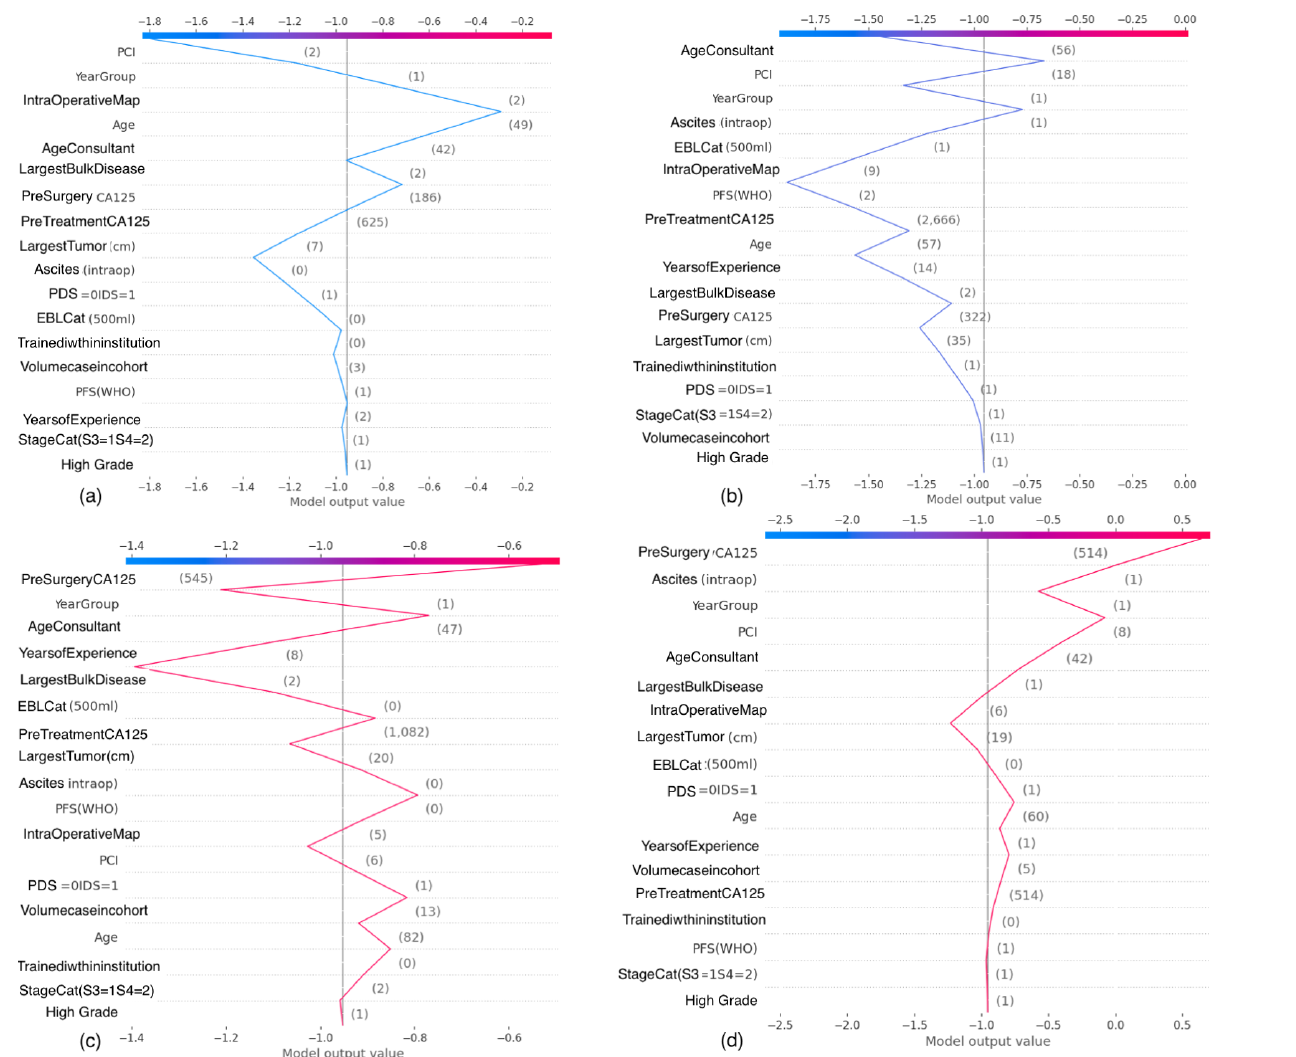
Figure 7. Examples of Decision plots based on feature integration by the XAI model into a single risk for prediction of surgical effort. For the probability of SCS > 4, blue features have values that increased the probability, while red features decreased the probability. The combination of impacts of all features is the predicted prediction risk for above threshold surgical effort. ( a , b ) The odds for SCS > 4 range between 1.40- and 1.80-fold higher than normal. ( c , d ) the odds for SCS < 5—which means that inomplete cytoreduction is most likely to happen—range between 1.53- and 1.8-fold higher than normal. Each feature impact value represents the change in risk when that feature’s value is known versus unknown. The examples clearly demonstrate the complex interactions between patients, surgeons, and ovarian cancer-specific features. SCS, Surgical Complexity